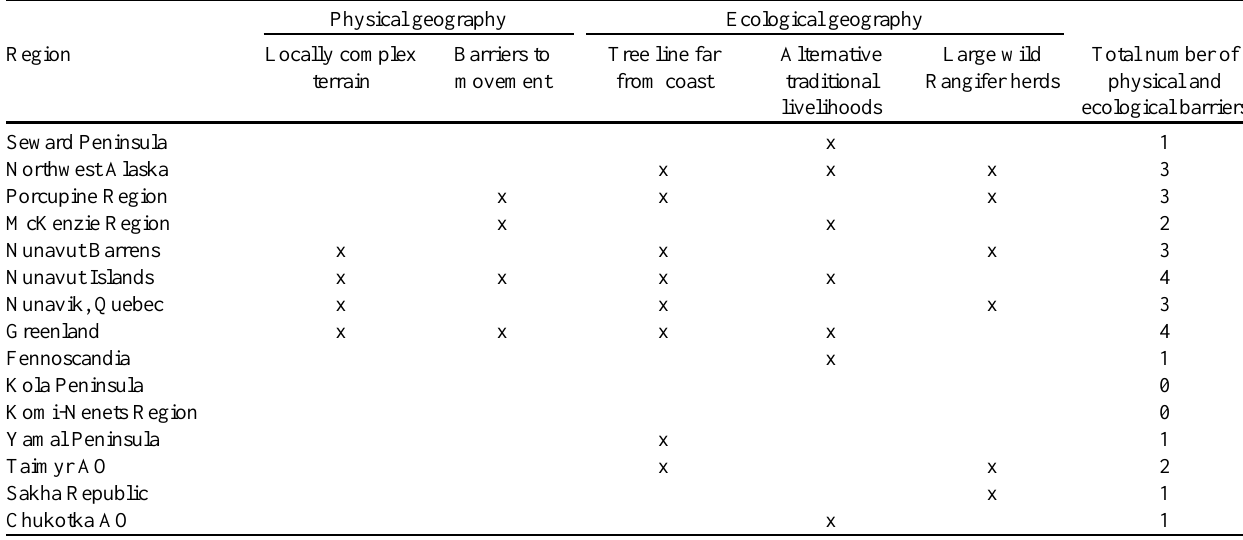
Table 2. Physical and ecological impediments to reindeer herding in various Arctic regions Physical geography Ecological geography Region Locally complex Barriers to Tree line far Alternative Large wild Total number of terrain movement from coast traditional Rangifer herds physical and livelihoods ecological barriers Seward Peninsula x 1 Northwest Alaska x x x 3 Porcupine Region x x x 3 McKenzie Region x 3 x x x x 4 3